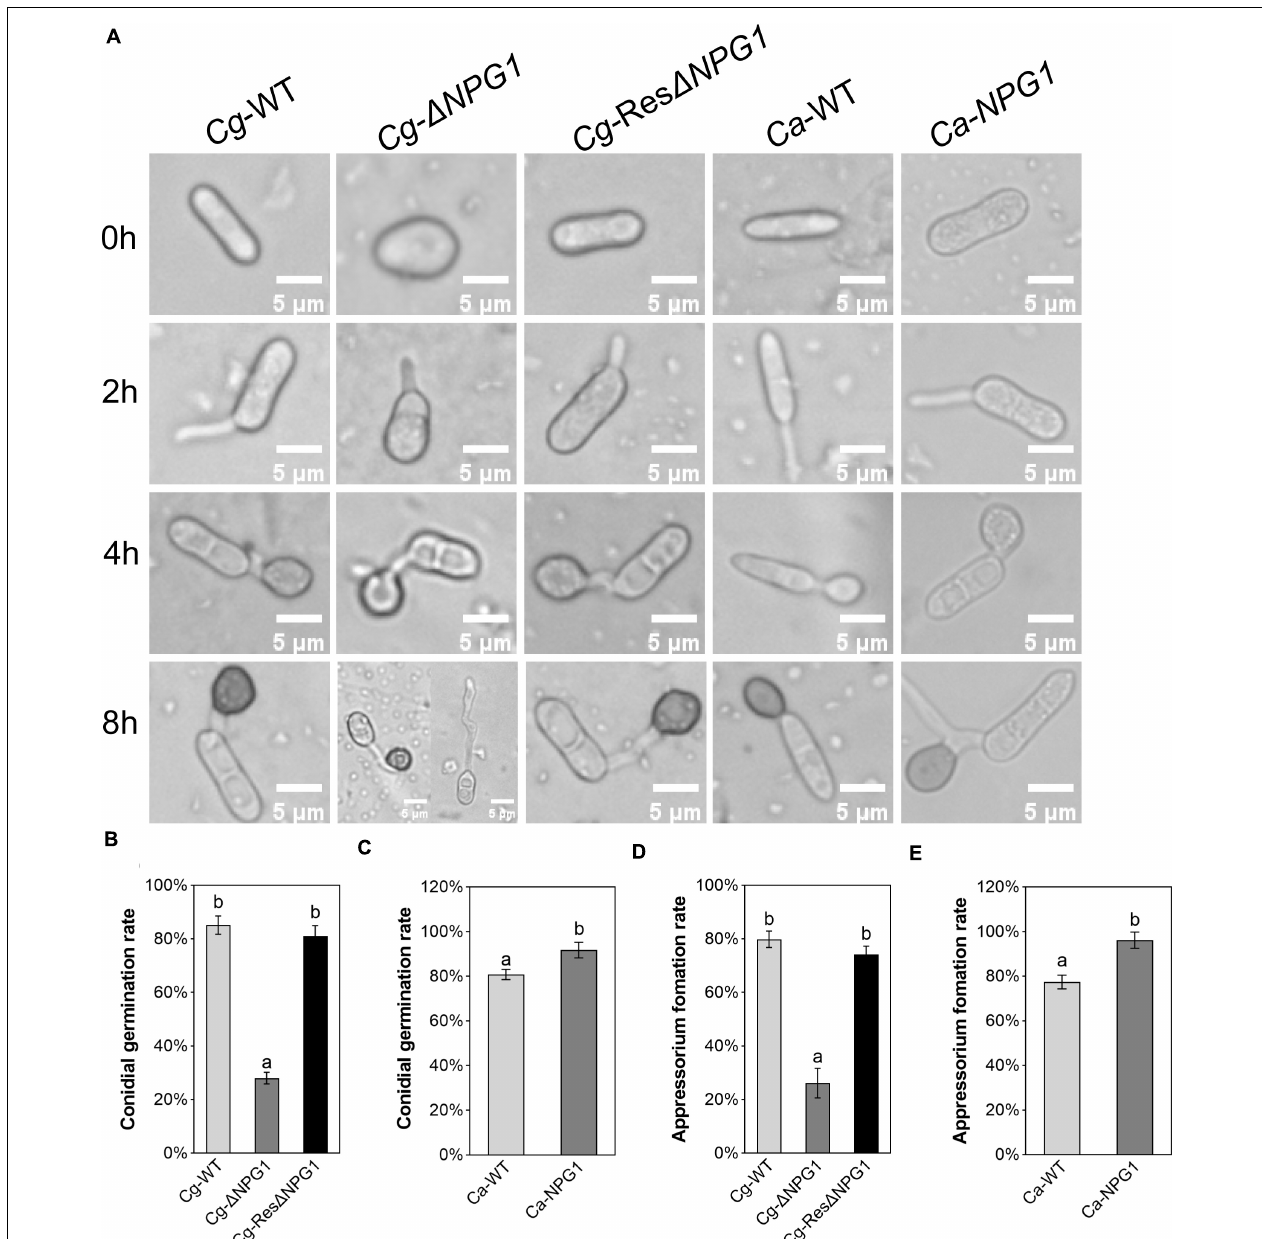
FIGURE 6 | Conidial germination and appressorium formation assay of CgNPG1 deletion mutant and CgNPG1 heterologous expression mutant. (A) Appressorium development progress of Cg-WT, Cg- (cid:49) NPG , Cg-Res (cid:49) NPG1, Ca-WT, and Ca- NPG1 . (B) Conidia germination rates of Cg-WT, Cg- (cid:49) NPG , Cg-Res (cid:49) NPG1 at 4 h time intervals. (C) Conidia germination rates of Ca-WT and Ca- NPG1 at 4 h time intervals. (D) Appressorium formation rates of Cg-WT, Cg- (cid:49) NPG , Cg-Res (cid:49) NPG1 at 8 h time intervals. (E) Appressorium formation rates of Ca-WT and Ca- NPG1 at 8 h time intervals. Error bars indicated standard deviation, and columns with different letters indicate significant difference ( P <